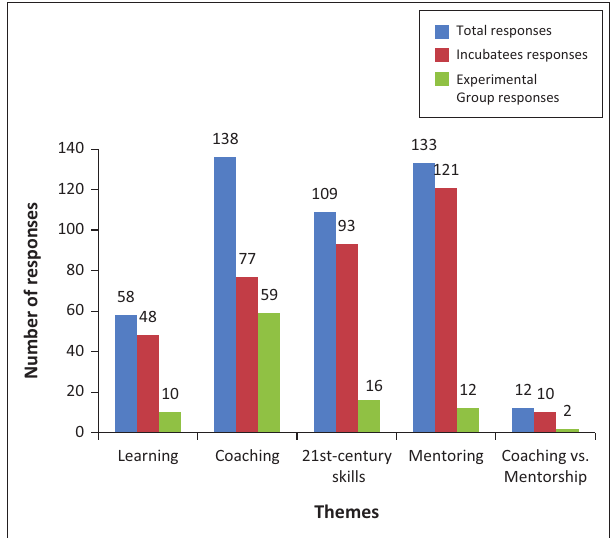
FIGURE 1: Graph showing total coded responses per